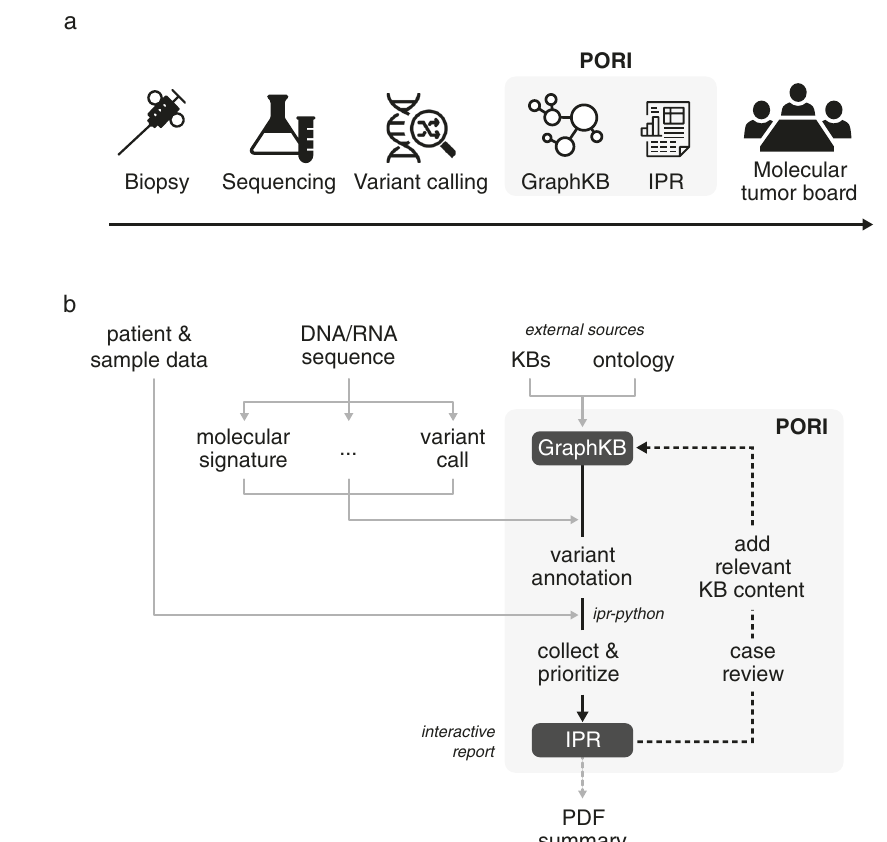
Fig. 1 Platform of Oncogenomic Reporting and Interpretation (PORI) overview. PORI Design showing both the placement of PORI within a precision oncology work fl ow ( a ) and the process of generating a report ( b ). PORI is used for the interpretation and reporting of genomic fi ndings from tumour sequencing. Sequencing Data is taken as input to a number of bioinformatic pipelines and analyses de fi ned by the user. The results of these are loaded by the IPR report python adapter (ipr-python) and annotated with information from GraphKB. After annotation, the results are collated and prioritized based on matches for output into a report using the IPR interactive web platform. This is optionally manually reviewed by the case analyst who may add content to GraphKB as part of their literature review for the case and re-generate the report to include the newly added content. This report is shared with the molecular tumour board (MTB) to inform clinical